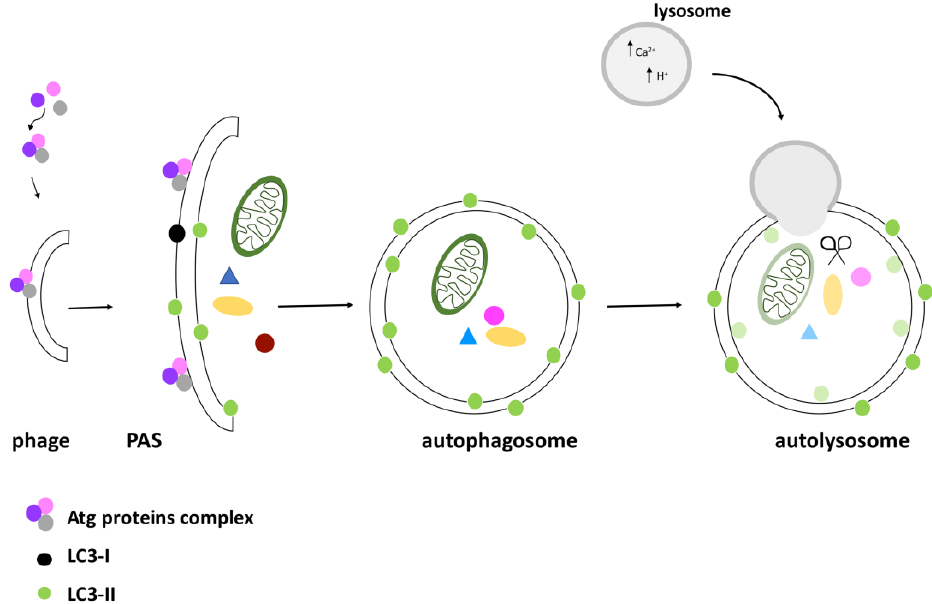
Figure 1. Schematic representation of autophagosome formation. The activation of the ATG (AuTophaGy-related) complex induces the formation of a pre-autophagosomal structure (PAS). The recruitment of proteins and lipids induces membrane expansion and then its closure to form the autophagosome, enveloping proteins and organelles destined for degradation. An important step in the PAS elongation is the recruitment of the protein light chain 3 (LC3), an important marker of autophagic flux. After induction of autophagy, LC3 is cleaved and turned into its activated form, LC3-I. When recruited to the autophagosome, LC3-I is converted to its lipidated form LC3-II, that can bind on both the inner and outer surface of the autophagosome. In the final stage, the autophagosome merges with the lysosome, and the cargo is completely degraded.